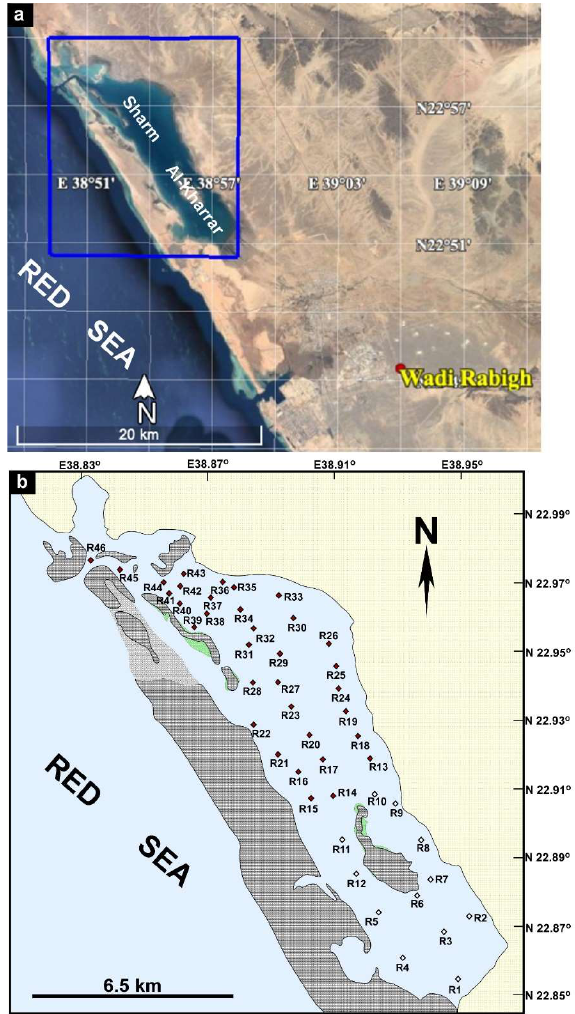
Figure 1. Google Earth map showing the location map of the Sharm Al-Kharrar ( a ) and a map showing sampling sites ( b ).